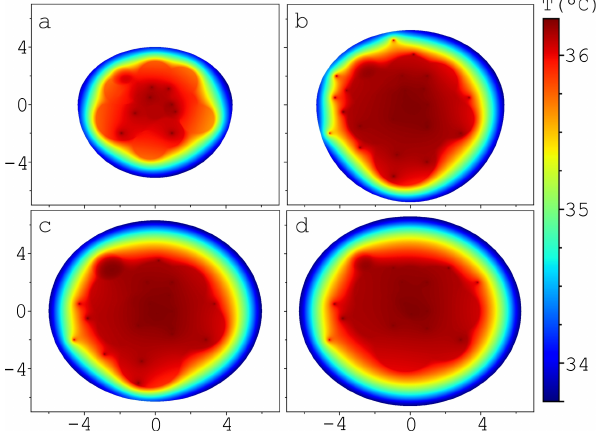
Figure 18. Thermodynamic temperature distributions at different depths from the nipple on flat sections: L ( can ) = 2 cm ( a ); L ( can ) = 3 cm ( b ); L ( can ) = 4 cm ( c ); L ( can ) = 5 cm ( d ). The tumor is in the vicinity of measurement point “8”.